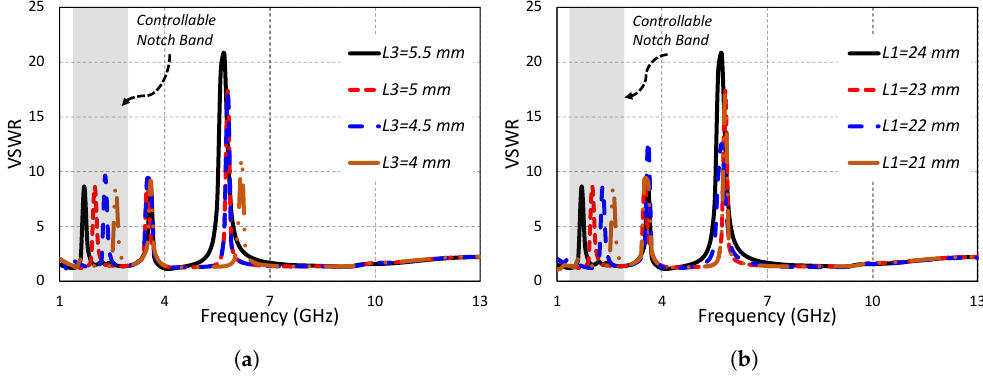
Figure 6. Independently-controllable lower notch band by varying ( a ) L3 and ( b ) L1